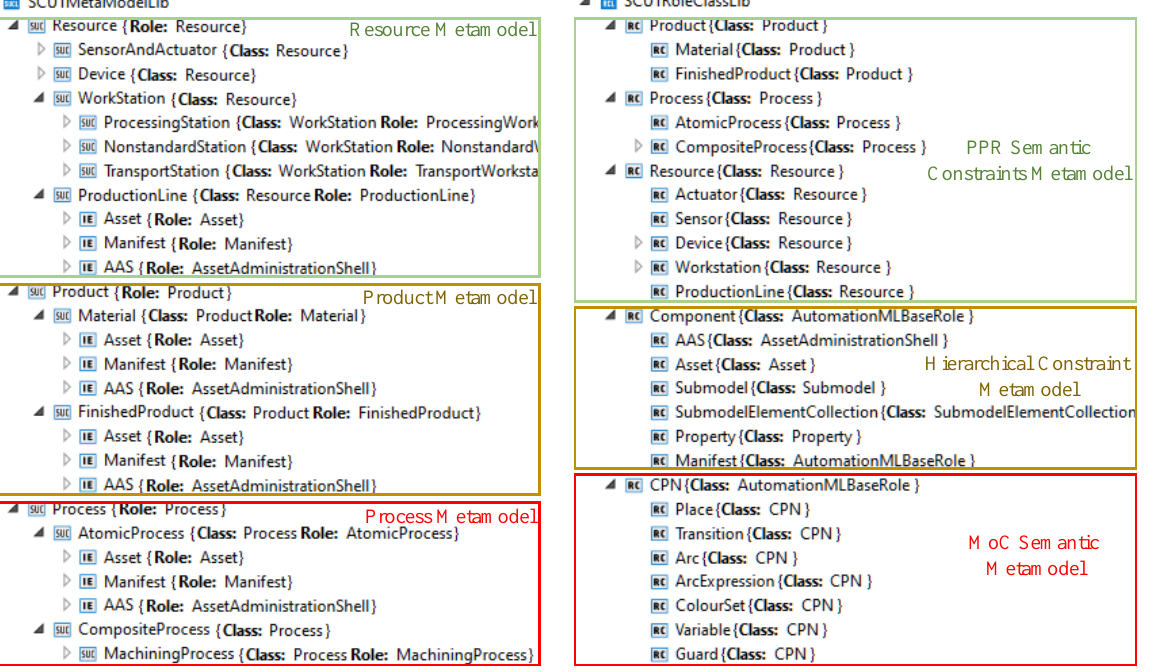
Figure 4. Metamodel of FDML in AutomationML